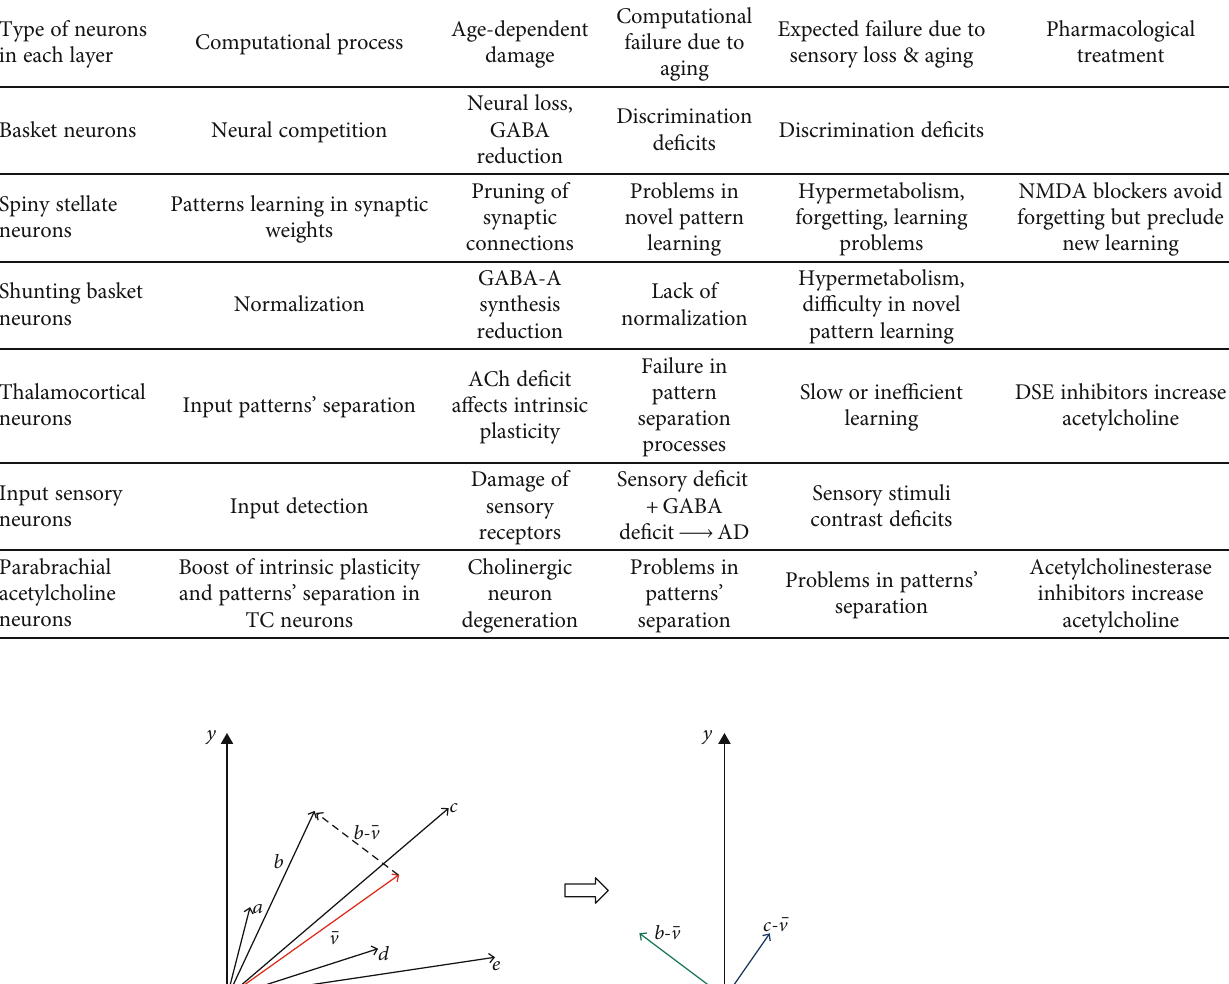
Table 2: Here, we list the computational processes performed by each type of neuron in each layer of the koniocortex model. The consequences of several lesions (due to age) in these di ff erent layers are also mentioned. When these lesions coincide with a reduction of sensory stimulation, we expect a further degree of deterioration that resembles AD. In the last column, we enumerate some pharmacological treatments to counteract the failures listed in previous columns.